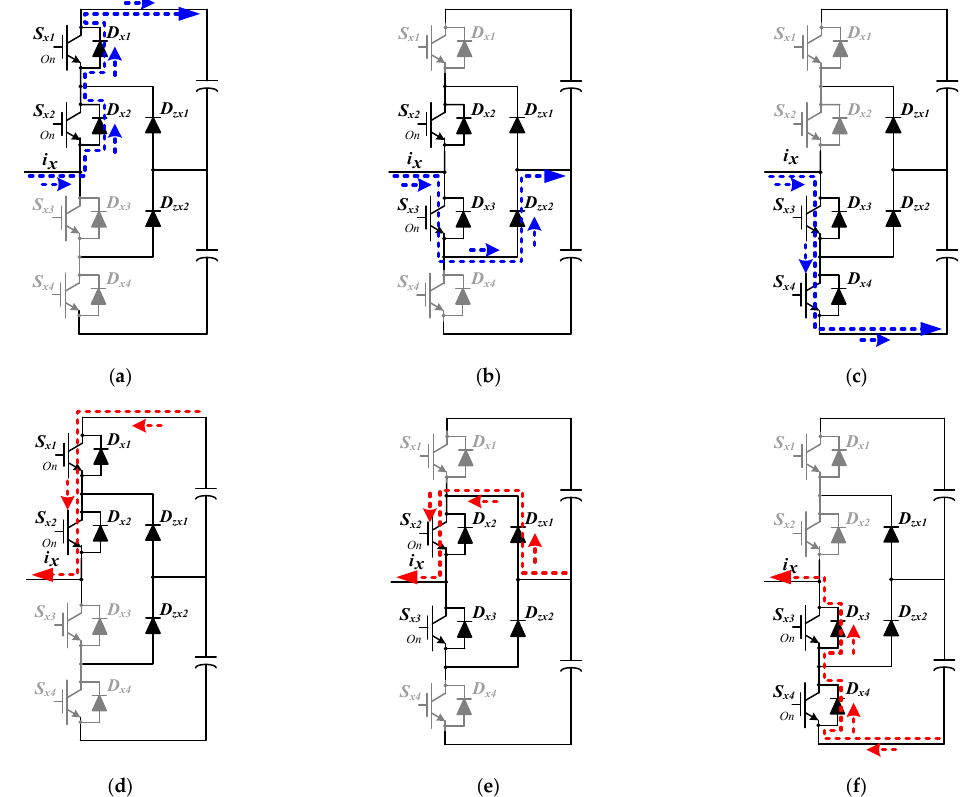
Figure 2. Current paths according to switching states and the current direction: ( a ) P-state, i xs > 0; ( b ) O-state, i xs > 0; ( c ) N-state, i xs > 0; ( d ) P-state, i xs < 0; ( e ) O-state, i xs < 0; ( f ) N-state, i xs < 0.